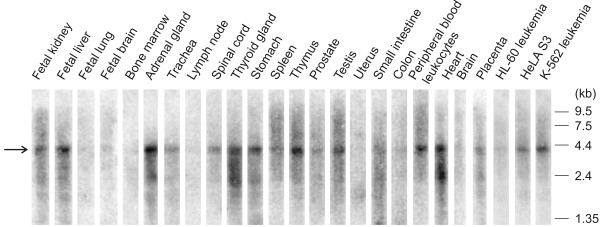
Northern blot analysis of ABCA17P in various human tissues. Northern blot demonstrating robust expression of the ABCA17P full-length transcript (arrow) in a variety of human tissues. A size marker is indicated for orientation.